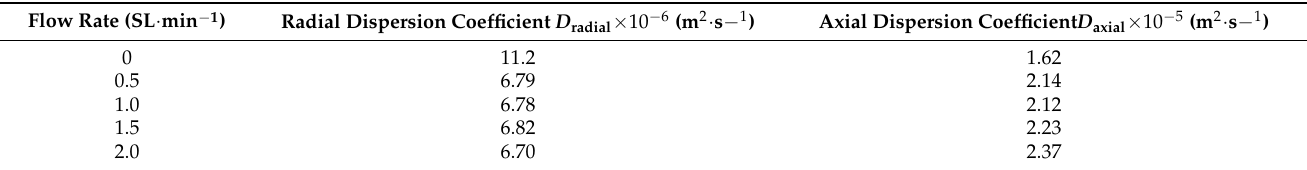
Table 1. The measured radial and axial displacement coefficients of flow within the ceramic monolith. Flow Rate (SL · min − 1